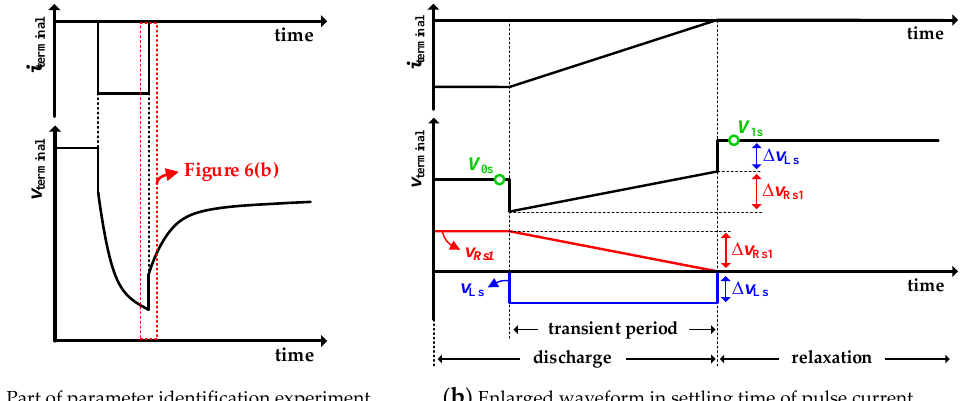
Figure 5. Conceptual figure of strategy for identification of L s .